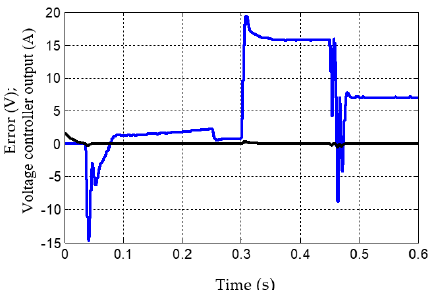
Figure 14. The error (in black) and the output (in blue) of the voltage controller when a step variation of the load occurs.